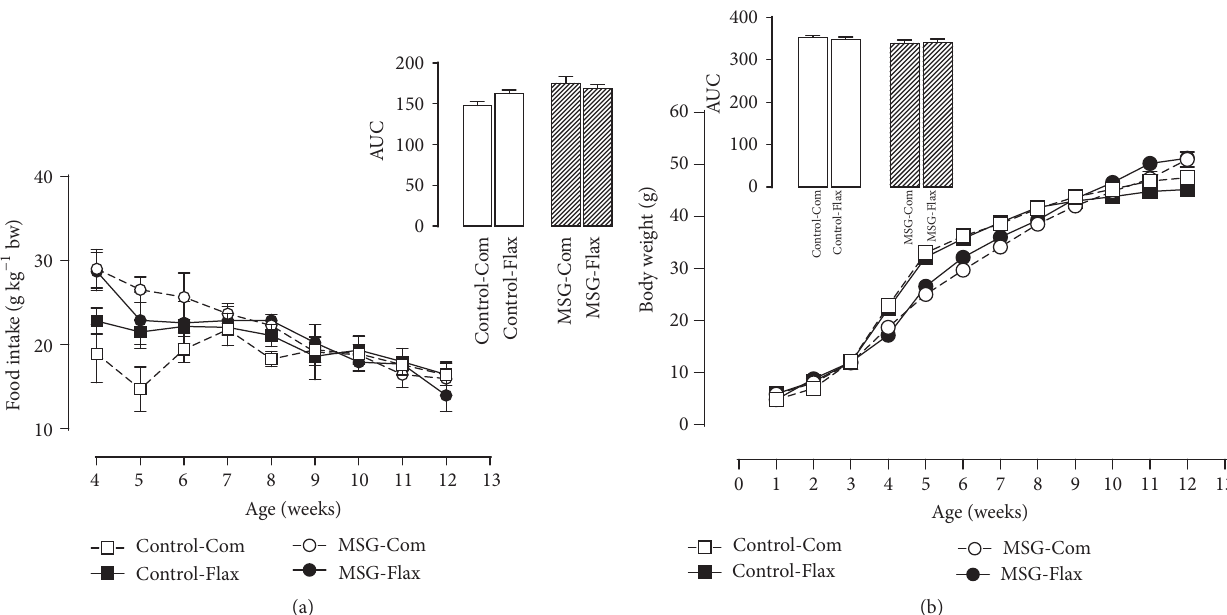
Figure 1: Effects of maternal flaxseed supplementation on offspring’s food intake (a) and body weight progression (b). The data represent the mean ± SEM of 5 different litters ( 𝑛 = 5 ). The insets on each bar represent the area under the curve (AUC) from the food intake and body weight progression curves, respectively. The data were evaluated by one-way